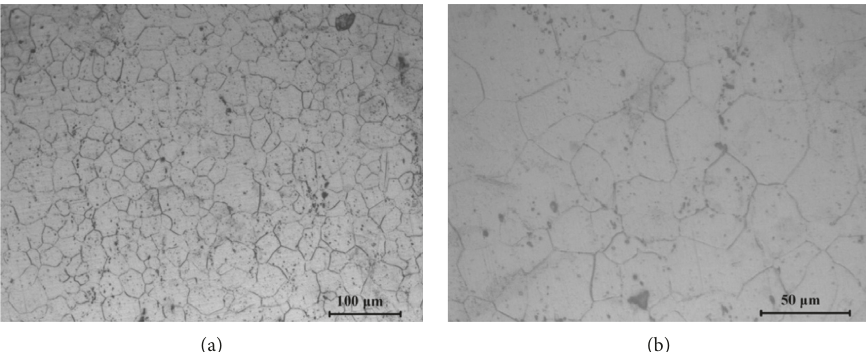
Figure 1: Microstructures of the AQ80M alloy with different magnifications.